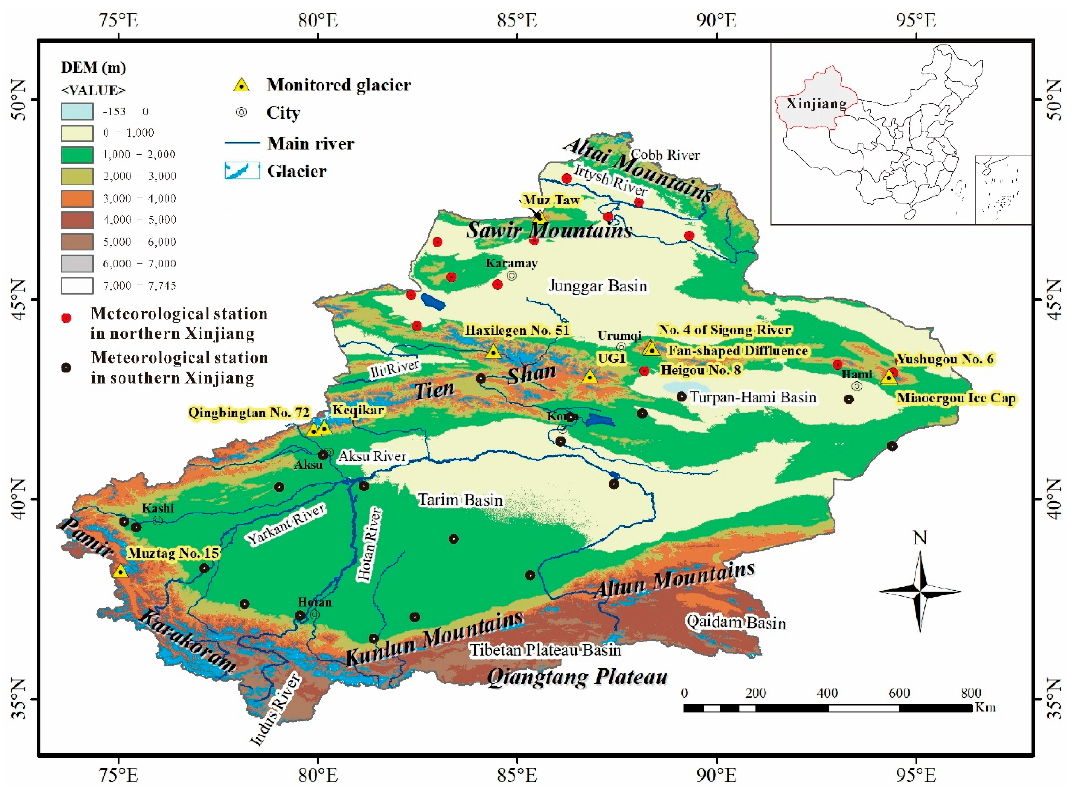
Figure 1. Geographical distribution of glaciers, monitored individual glacier and meteorological stations in Xinjiang, China.